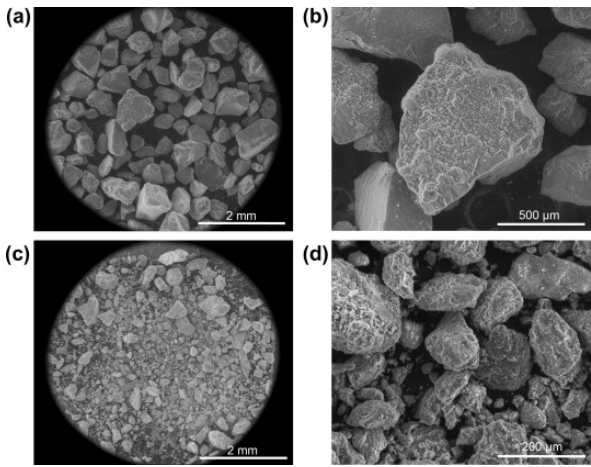
Figure 5: SEM images of iron ore tailings [28]